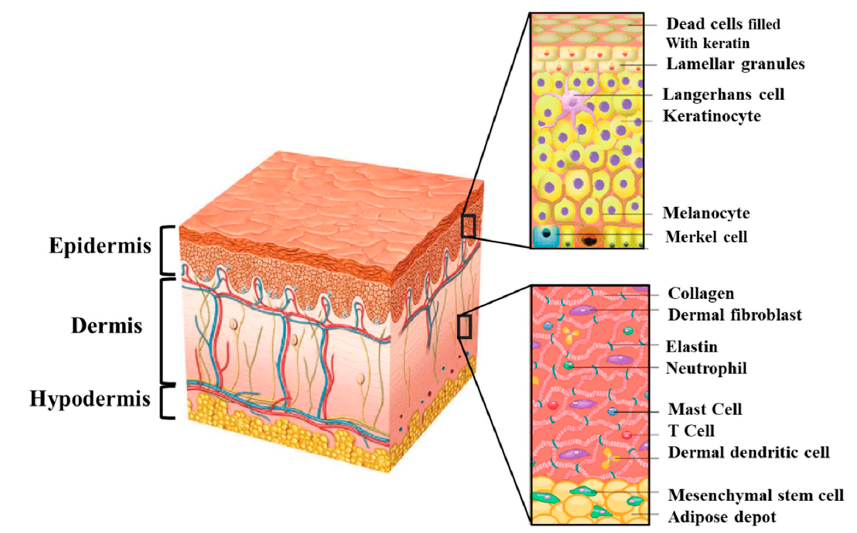
Figure 1. The structure of human skin consisting of three primary layers—the epidermis, the dermis, and the hypodermis. The two inserts (right site) show their detailed cellular structure at higher magnification. The epidermis consists mainly of keratinocytes, melanocytes, and Langerhans cells. The dermis contains fibroblasts, neutrophils, mast cells, and dermal dendritic cells embedded within the dermal matrix rich in collagen and elastin. Beneath the dermis lies the subcutaneous adipose tissue (hypodermis) containing mesenchymal stem cells.